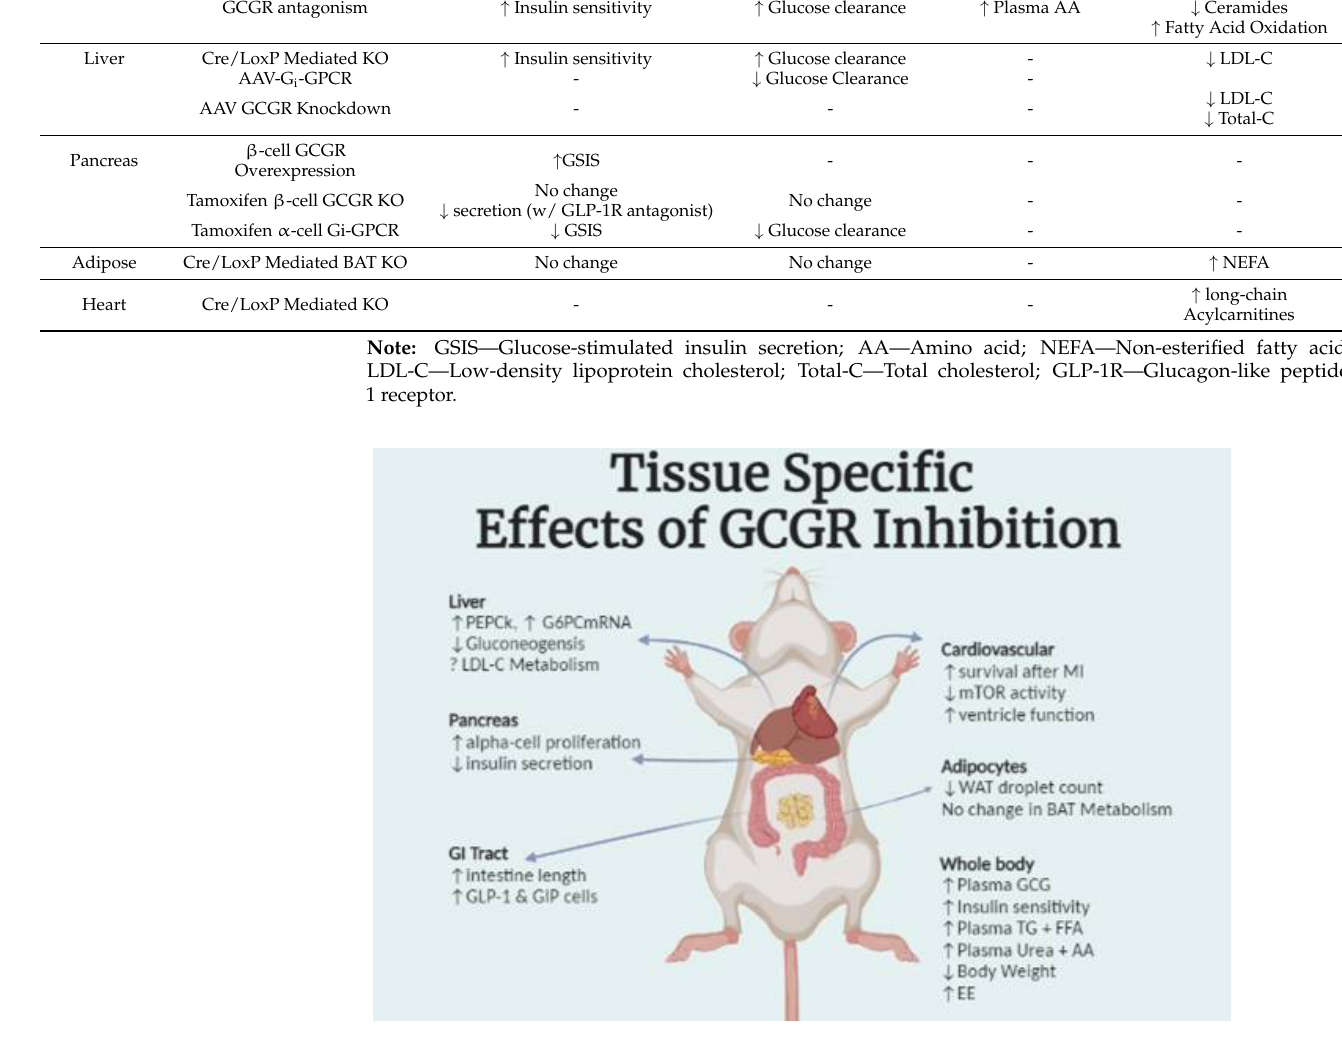
Figure 2. Visual summary of the physiological changes reported in various GCGR-KO models. Ab- breviations: PEPCK phosphoenol pyruvate carboxykinase 1; G6PC glucose-6-phosphatase; LDL-C low density lipoprotein cholesterol; MI myocardial infarction; mTOR mechanistic target of rapamy- cin; WAT white adipose tissue; BAT brown adipose tissue; TG triglyceride; FFA free fatty acid; AA amino acid; EE energy expenditure.